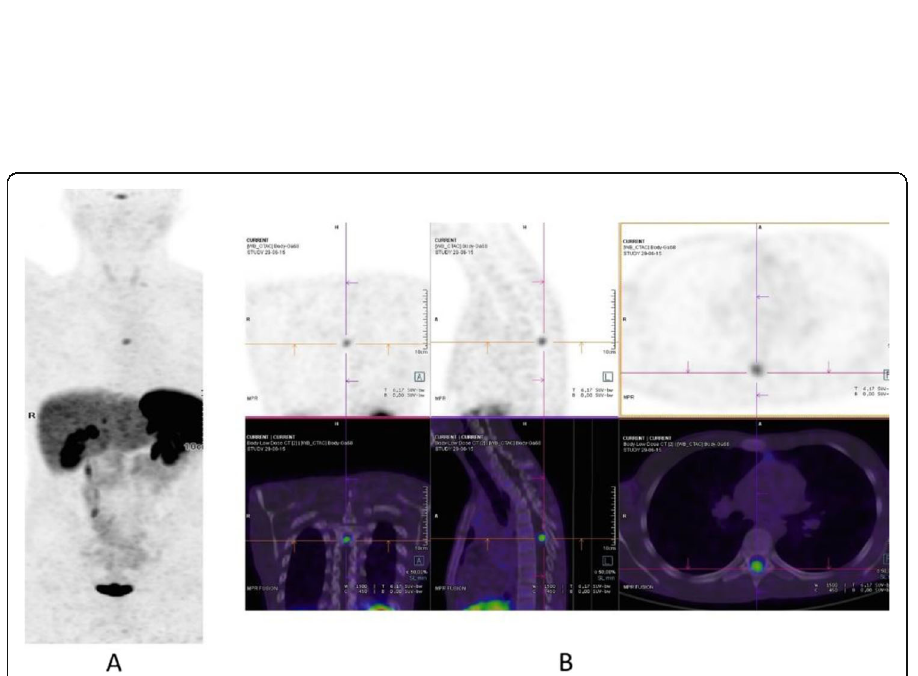
Fig. 57 68 Ga-DOTA peptide, suspicion of NET, specificity. Clinical history : 17 y.o. boy with known Von Hippel-Lindau disease. Increased level of pancreatic polypeptide. PET/CT findings : 68 Ga-DOTANOC PET shows an intramedullary focus of increased uptake at the level of T8 ( a MIP, b PET and fused PET/CT), corresponding to a